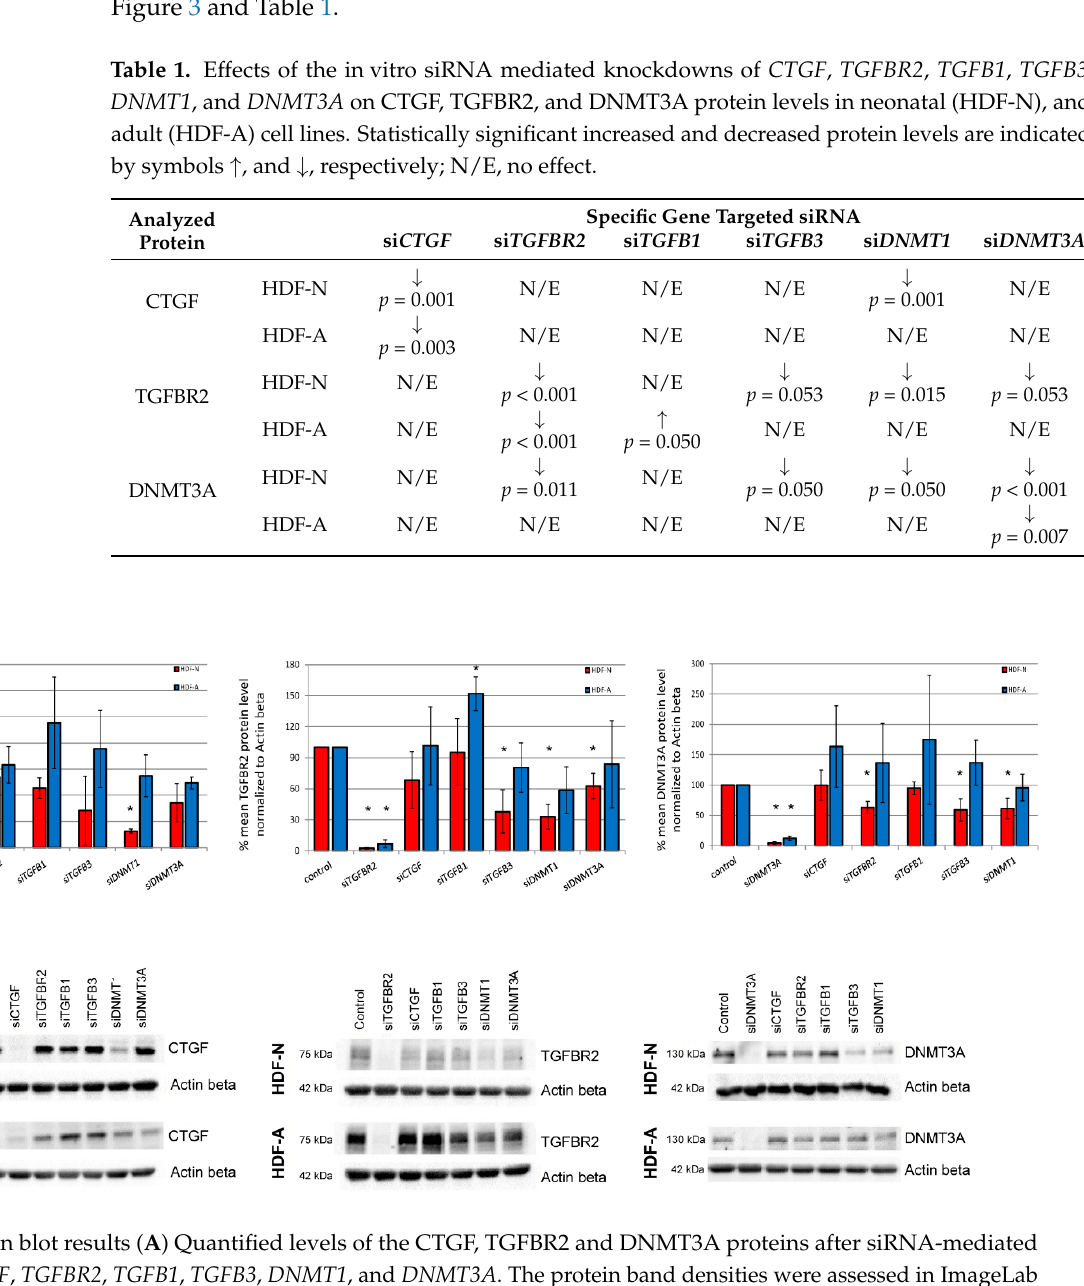
Table 1. Effects of the in vitro siRNA mediated knockdowns of CTGF , TGFBR2 , TGFB1 , TGFB3 , DNMT1 , and DNMT3A on CTGF, TGFBR2, and DNMT3A protein levels in neonatal (HDF ‐ N), and adult (HDF ‐ A) cell lines. Statistically significant increased and decreased protein levels are indicated by symbols ↑ , and ↓ , respectively; N/E, no effect. Analyzed Protein